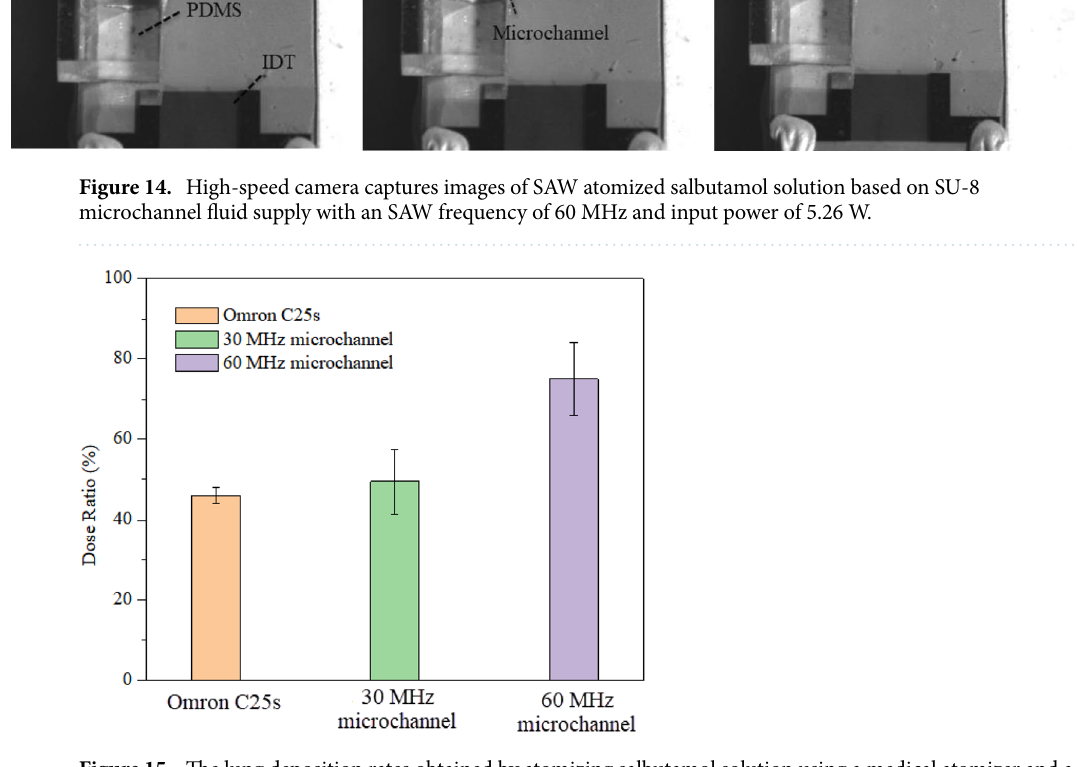
Figure 15. The lung deposition rates obtained by atomizing salbutamol solution using a medical atomizer and a SAW atomizer. Note that the SAW atomized salbutamol solution based on SU-8 microchannel fluid supply with a flow rate of 90 μl/min and input power of 5.26